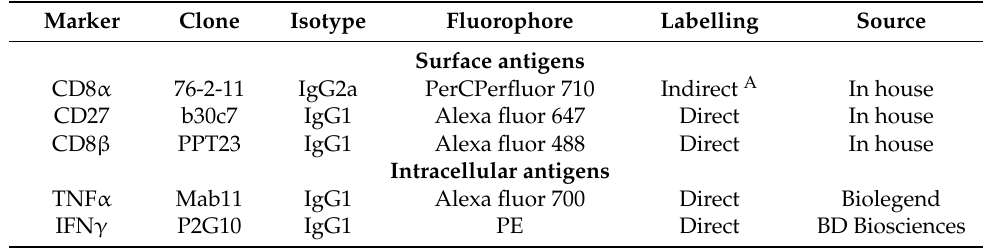
Table 1. List of antibodies used in the ICS